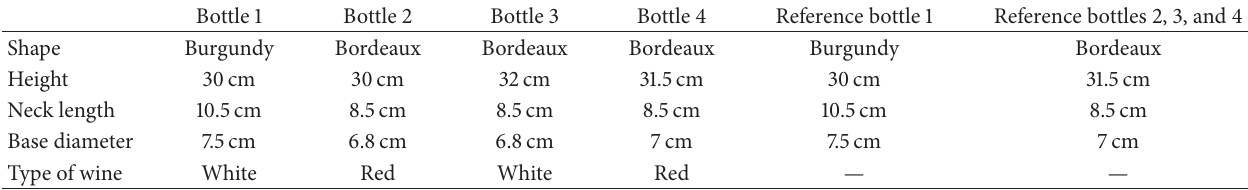
Table 3: Characteristics of the bottles of wine used in the tests.